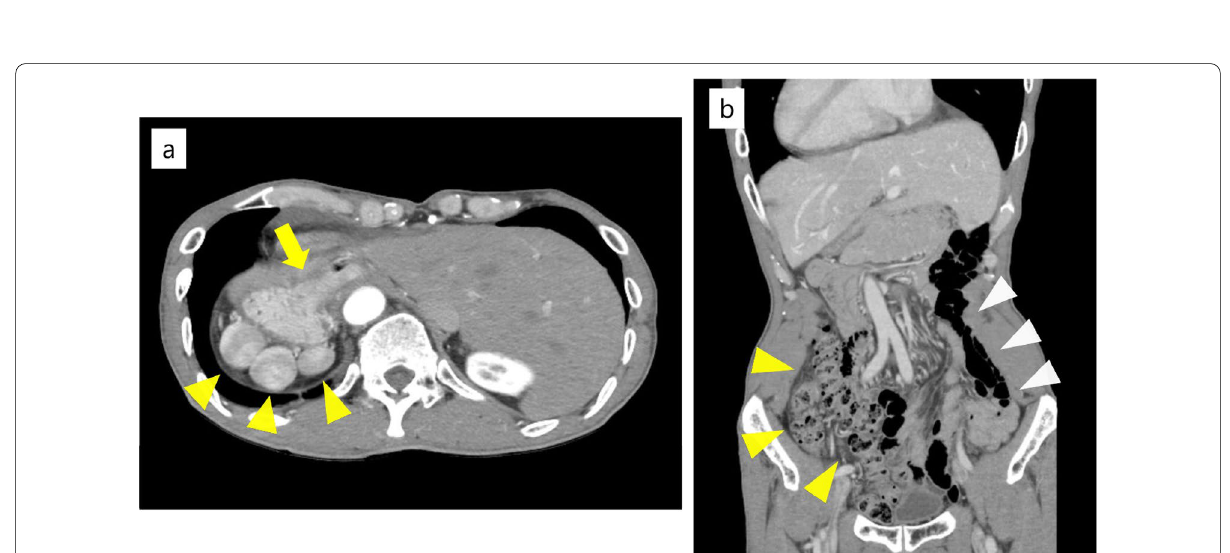
Fig. 2 Computed tomography findings. a Situs inversus totalis, irregular thickening of the gastric wall (yellow arrow), and multiple spleens (yellow arrowheads) were observed. b The large bowel was located predominantly in the right abdomen (yellow arrowheads), and the small bowel was located predominantly in the left abdomen (white